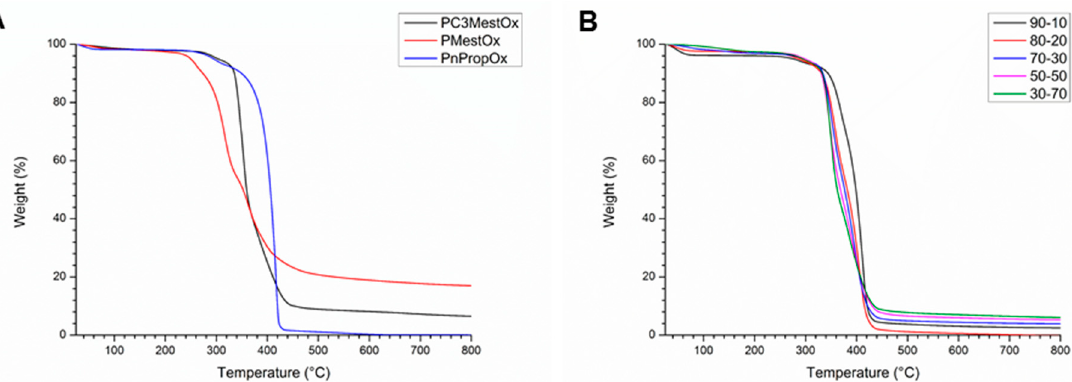
Figure 5. Thermogravimetric analysis of ( A ) PMestOx, PC3MestOx, and P n PropOx homopolymers and ( B ) P(EtOx–C3MestOx) copolymers.